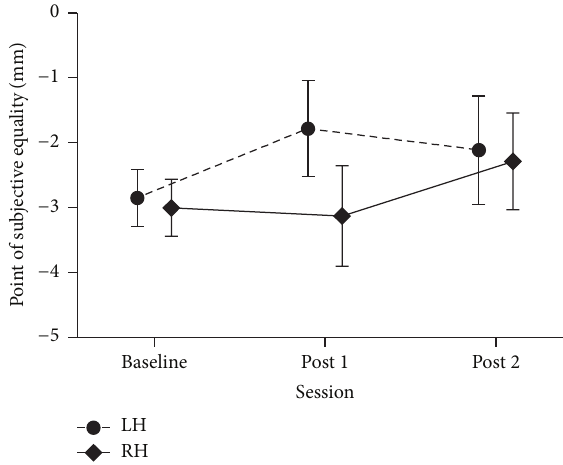
Figure 2: Average point of subjective equality (PSE) measured at baseline, post 1, and post 2 for each stimulated hemisphere group. PSE ( 𝑦 -axis) is represented in millimeters and error bars represent standard error of the mean